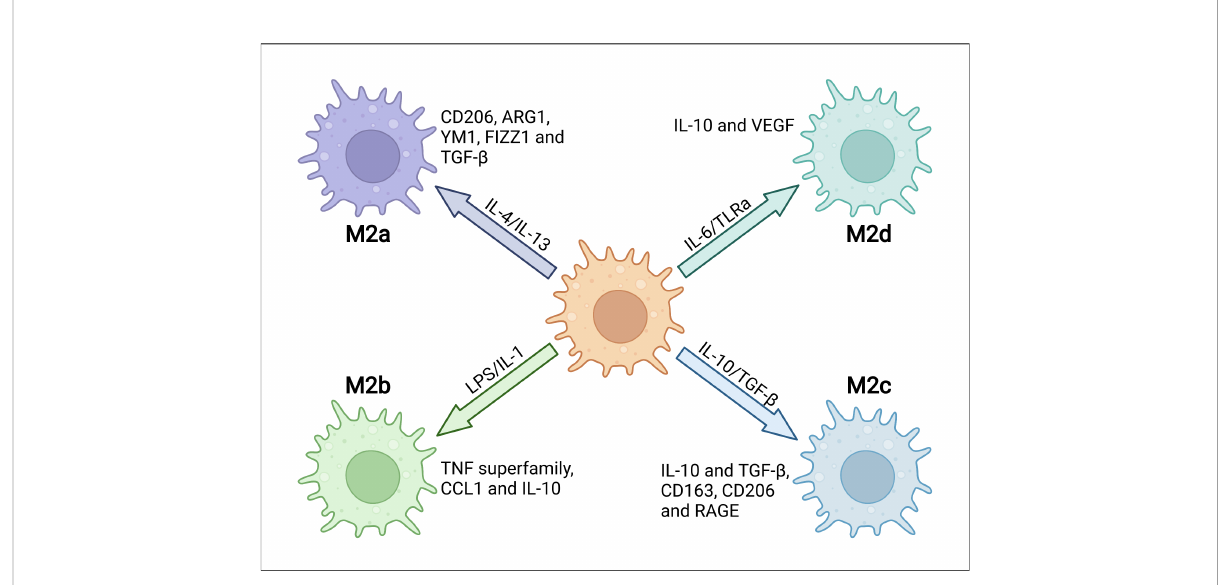
FIGURE 1 The heterogeneity and characterizations of M2 macrophages. M2 macrophages can be subgrouped into M2a, M2b, M2c and M2d depending on different microenvironmental stimuli. Speci fi c stimuli include, but are not limited to, IL-4 or IL-13 for M2a, LPS or IL-1 receptor ligands for M2b, IL-10 or TGF- b for M2c and IL-6 or Toll-like receptor agonists (TLRa) for M2d. Different subtypes express distinct markers, including intracellular proteins and secreted